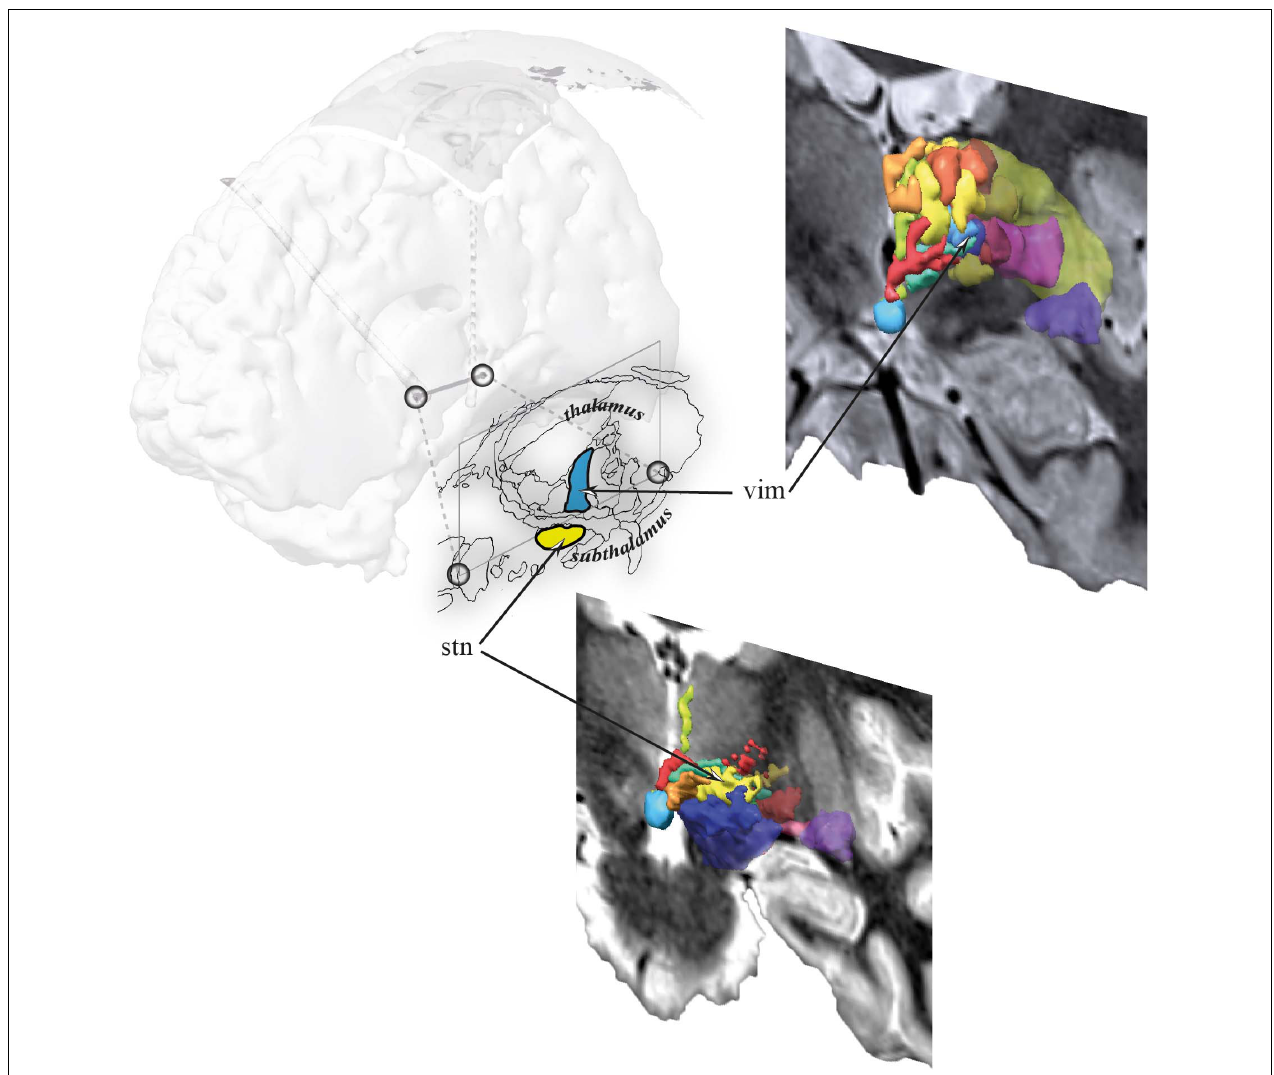
FIGURE 3 | Location of thalamic and subthalamic electrodes. Sagittal section 13.5 mm lateral to the midline plan (dark lines) and coronal MRI slices, going through the ventral intermediate nucleus (vim, blue; ventrolateral thalamus), and the area of subthalamic nucleus (stn, yellow;